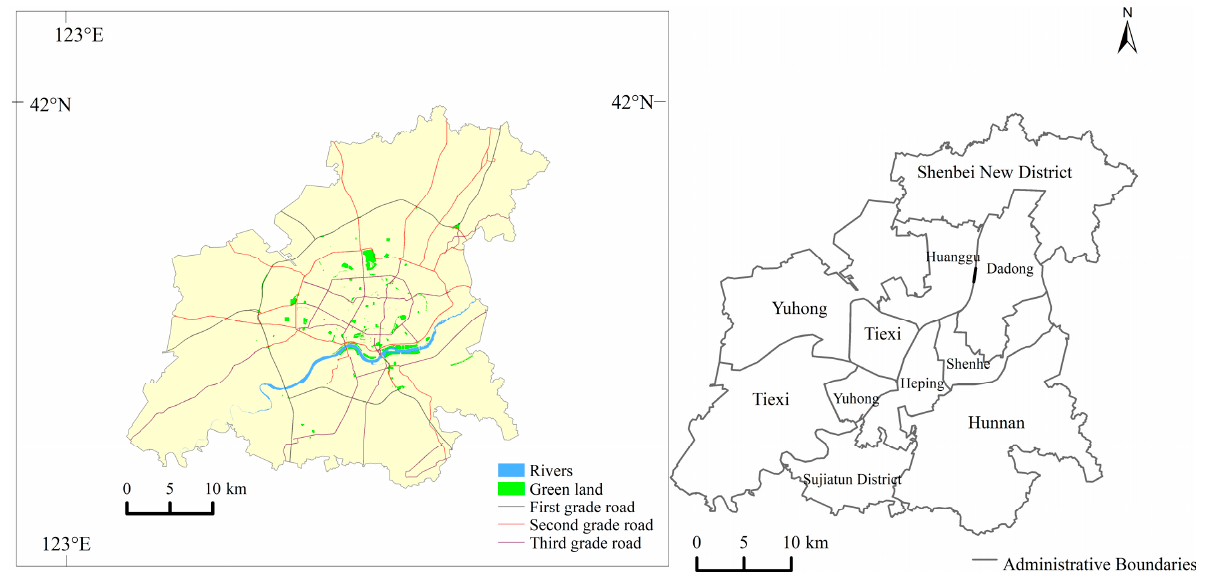
(Figure 1), with an area of 1254.88 km 2 and a population of 6.202 million in 2020.